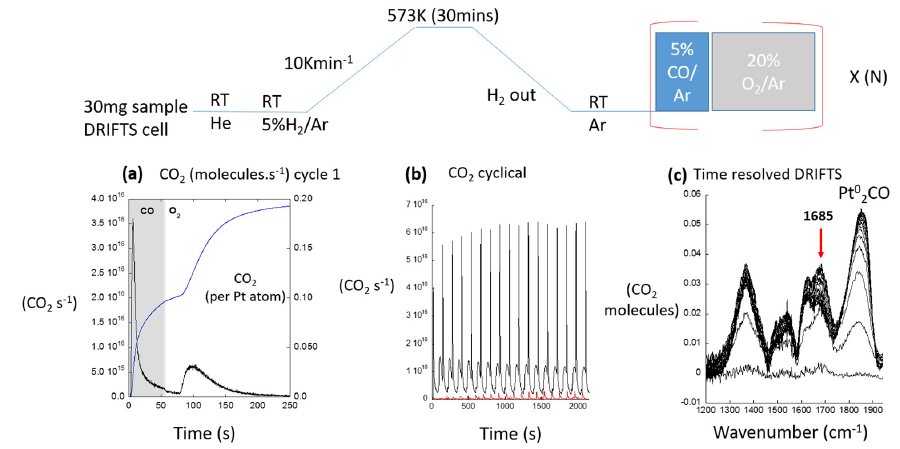
Figure 19. Top: experiment approach adopted in [168,169] to investigate CO oxidation at ambient temperature over a 5 wt % Pt/Al 2 O 3 catalyst (Type 94, Johnson Matthey). Bottom: ( a ) CO 2 production during a single cycle of periodic redox operation expressed as molecules CO 2 ·s − 1 (left axis) and as CO 2 atoms per Pt atom in the catalyst. ( b ) CO production over a sequence of redox cycles over the T-94 catalyst at RT (black) and an unloaded Al 2 O 3 sample (red). ( c ) Representative DRIFTS spectra in the 1240–1940 cm − 1 region during a CO cycle. The bridging CO species on reduced Pt is indicated, as is the band (at ca. 1685 cm − 1 ) that amongst the carbonate species observed is the only one whose temporal behavior precisely matches that observed in MS for the production of CO 2 . Adapted from Nat. Comms. 2015 , 6 , 8675 [168]. Copyright 2015, Nature Publishing Group and J. Am. Chem. Soc . 2016 ,